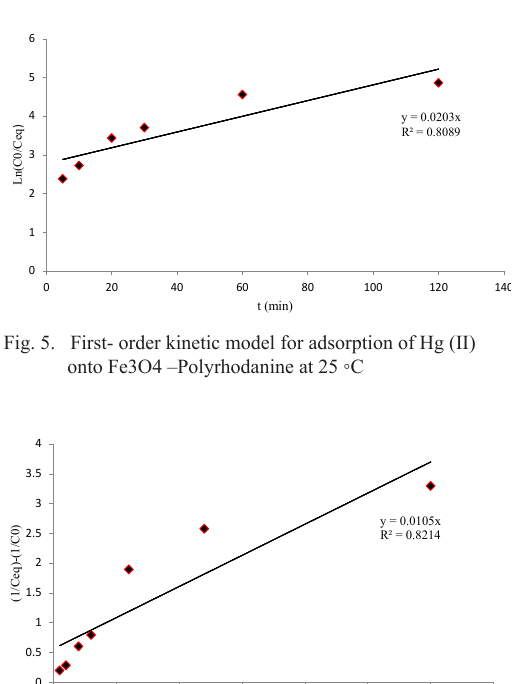
Fig.6: Second–orderkineticmodelforadsorptionofHg(II)ontoFe 3 O 4 –Polyrhodanineat25 ◦ C